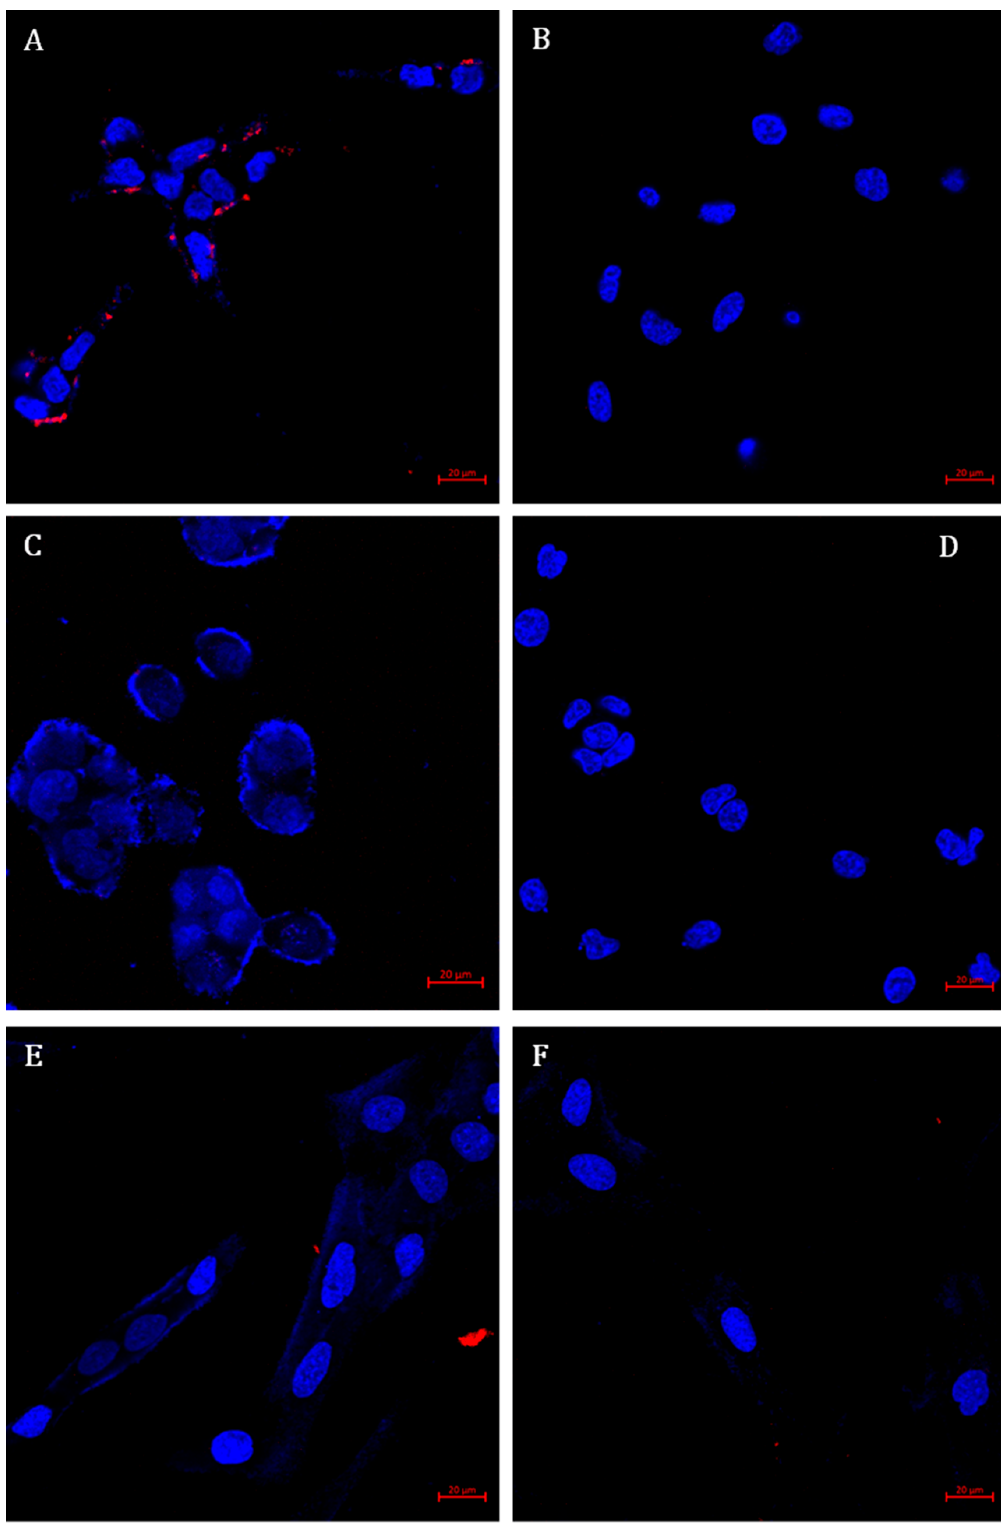
Figure 10. Specific internalization of targeted NPs. Confocal microscopy images of: ( A ) LNCaP; ( B ) PC-3; ( C ) NSCLC 1975; ( D ) HEK293; ( E ) BEAS2B; and ( F ) FSE cells, following 2 h incubation with targeted NPs labeled with Cy7 (at 37 °C; Samples were diluted 1:400 (v/v) in FBS-free medium). Nuclear DNA staining achieved with Hoechst 33342 (1 μ g/mL) is marked in blue, whereas NPs labeled with Cy7 are marked in red. Scale bars denote 20 μ m.